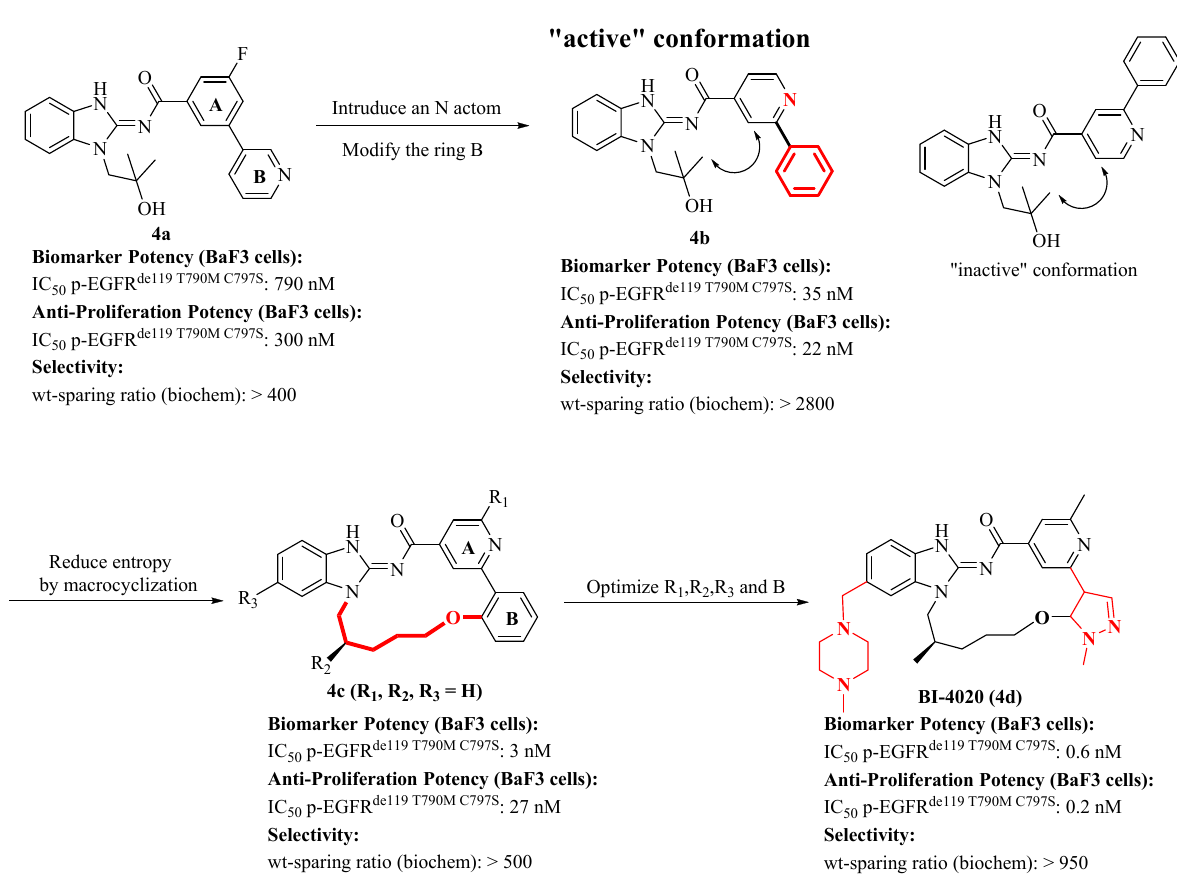
Figure 6. Structure-based design of BI-4020 ( 4d ).